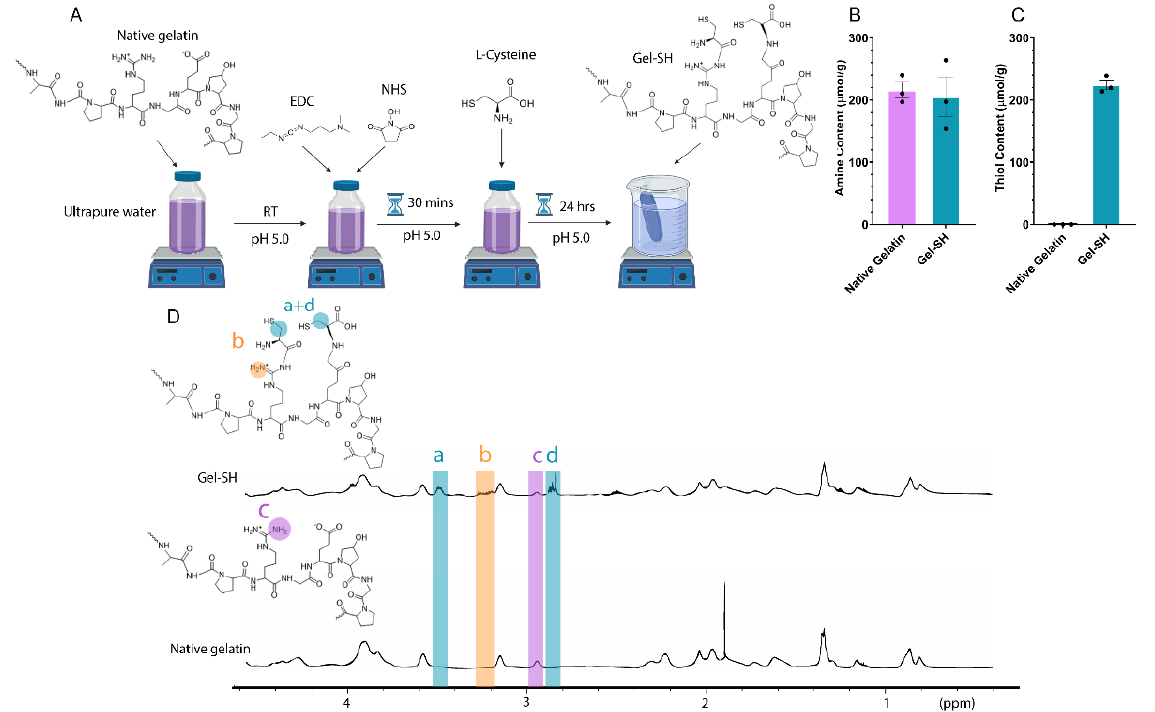
Figure 1. Thiolated gelatin (Gel-SH) functionalization. ( A ) Gel-SH synthesis schematic. Gel-SH was synthesized through 1-ethyl-3(3-dimethylamino)propyl carbodiimide (EDC)/ N -hydroxysuccinimide (NHS) conjugation of L-cysteine to the native fish gelatin backbone. ( B ) Amine content of Gel-SH determined via TNBS assay (mean ± SEM; n = 3); ( C ) Thiol content of Gel-SH determined via DTNB assay (mean ± SEM; n = 3); ( D ) 1 H-NMR of Gel-SH and native gelatin. Gelatin thiolation indicated by increase in signal at peaks (a), (b) and (d), and decrease in signal (c) in Gel-SH compared to native gelatin.